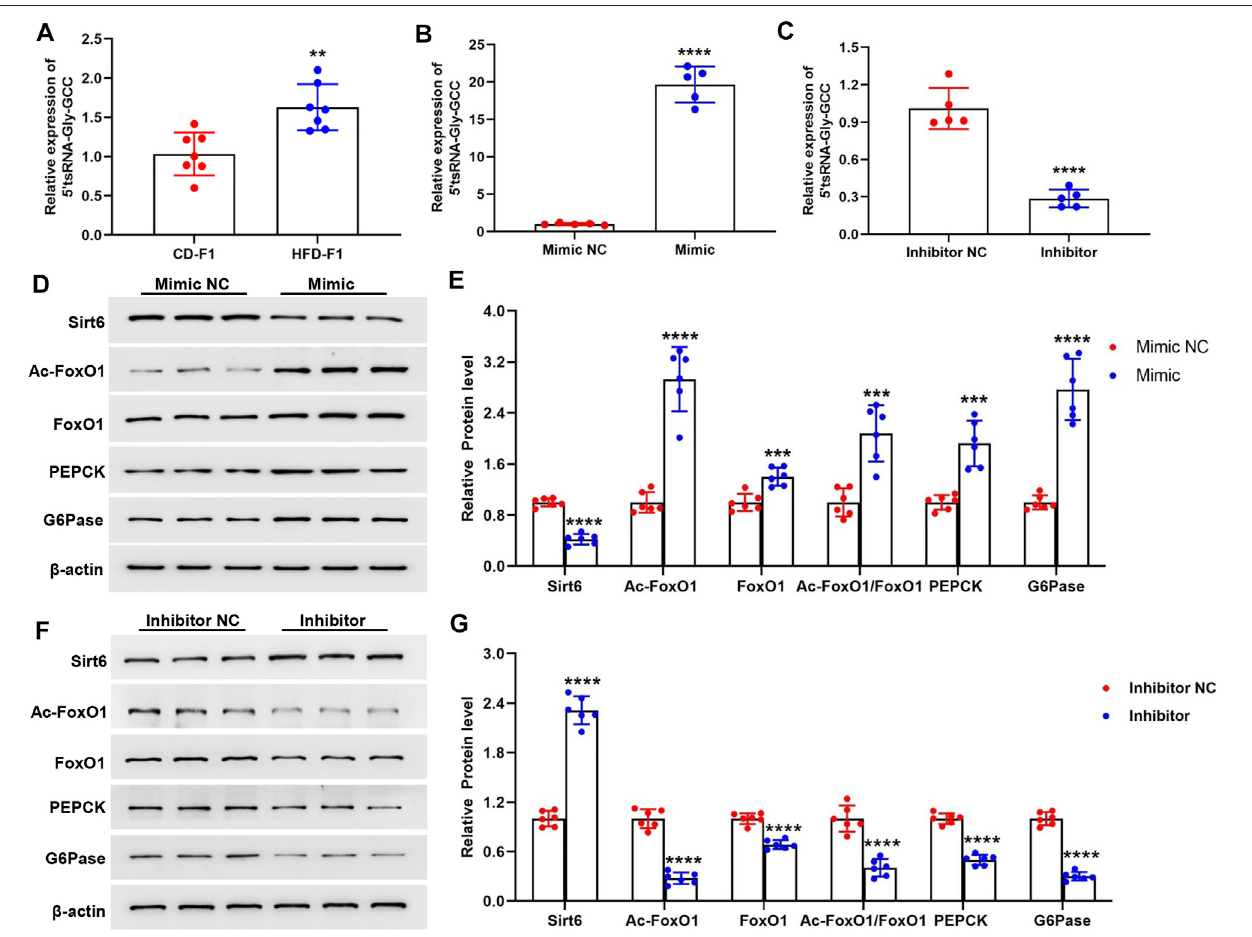
FIGURE 4 | 5 ′ tsRNA-Gly-GCC promotes gluconeogenesis in Hepa1-6 cells. (A) 5 ′ tsRNA-Gly-GCC level in liver tissue from HFD-F1 mice and CD-F1 mice was examined by Real-time PCR ( n = 7). (B , C) Real-time PCR analysis of 5 ′ tsRNA-Gly-GCC expression level after 5 ′ tsRNA-Gly-GCC mimic (B) and inhibitor (C) or non- targeted RNA (NC) into hepa1-6 cells 24 h ( n = 5). (D , E) Hepa1-6 cells transfected with 5 ′ tsRNA-Gly-GCC mimic 48 h, Sirt6, Ac-FoxO1, FoxO1, Ac-FoxO1/FoxO1, PEPCKandG6Paseproteinexpression wasdetectedbywesternblotanalysis( n =6). (F , G) Hepa1-6cellstransfectedwith5 ′ tsRNA-Gly-GCCinhibitor48